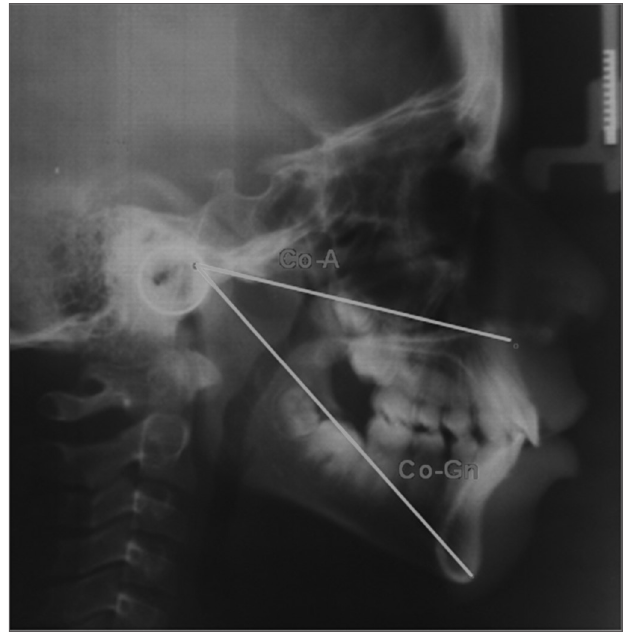
Figura 4. CoA e CoGn - CoA, distância linear do ponto Condílio até o ponto A; CoGn,distância linear do ponto Condílio até o ponto